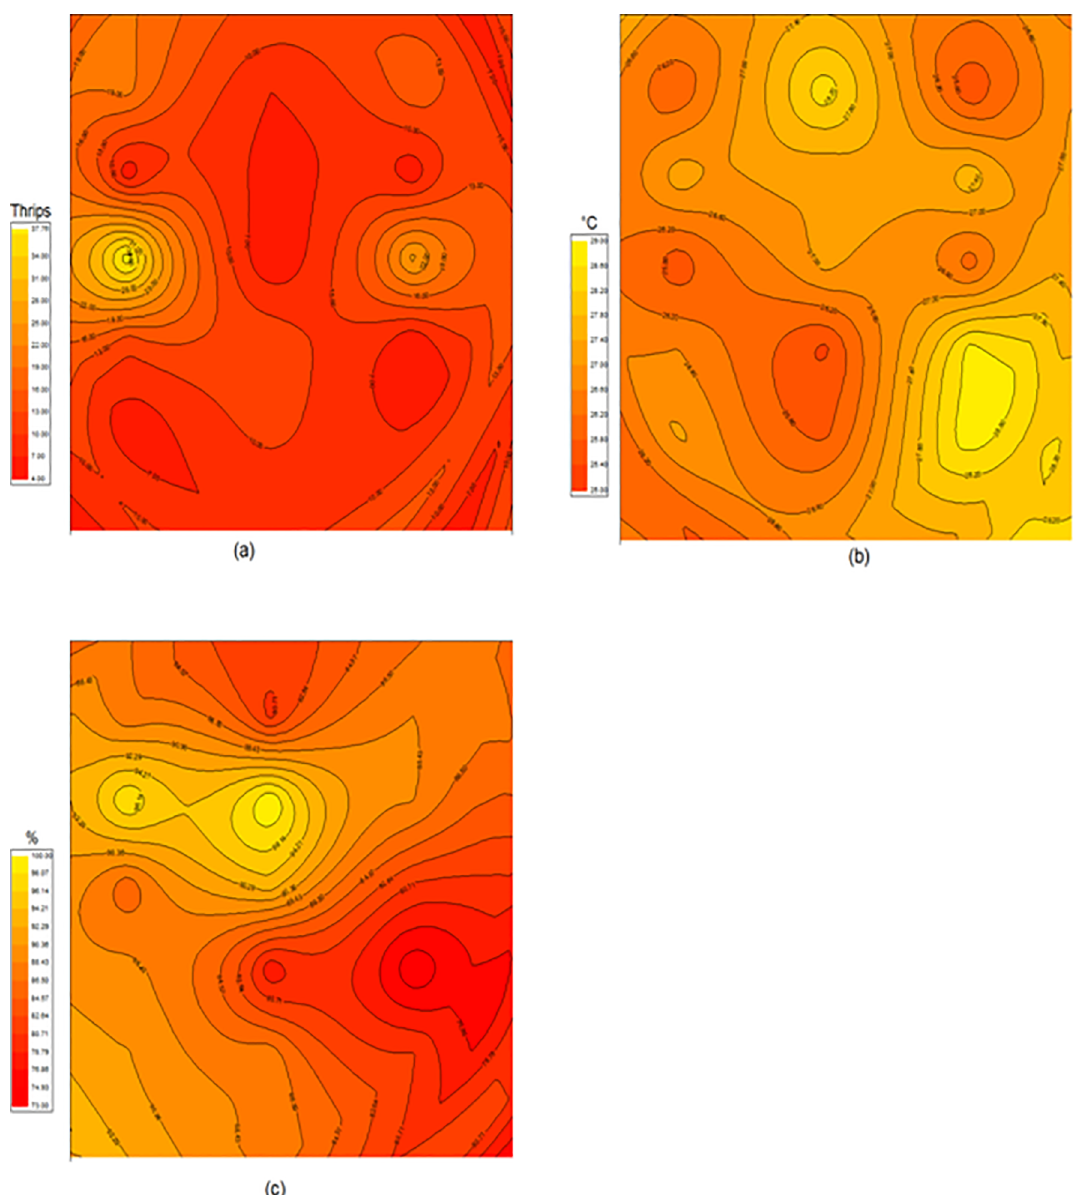
Fig 3. Contour maps of the (a) thrips population size (b) weekly mean diurnal temperature and (c) weekly mean air humidity within the experimental